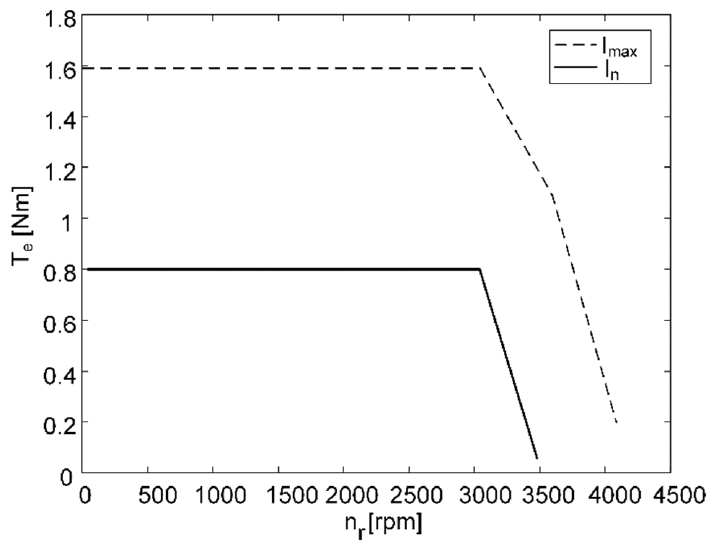
Figure 11. Target torque-speed curves at nominal (I n ) and maximal (I max ) current.